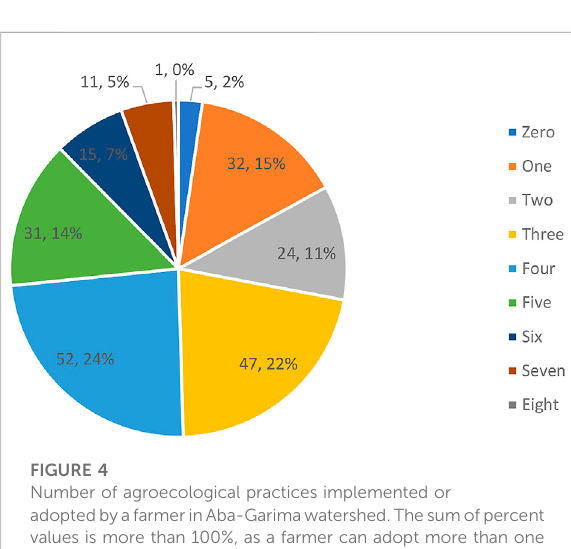
FIGURE 4 Number of agroecological practices implemented or adoptedbyafarmerinAba-Garimawatershed.Thesumofpercent values is more than 100%, as a farmer can adopt more than one agroecological